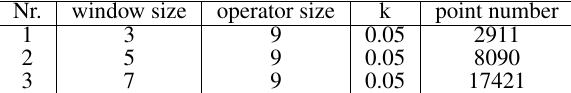
Table 1. Parameter settings for keypoint detection in IR